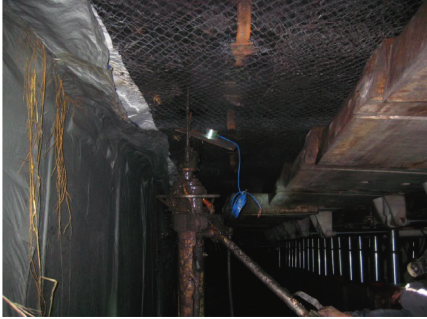
Figure 15: Installation of the roof pressure sensor.